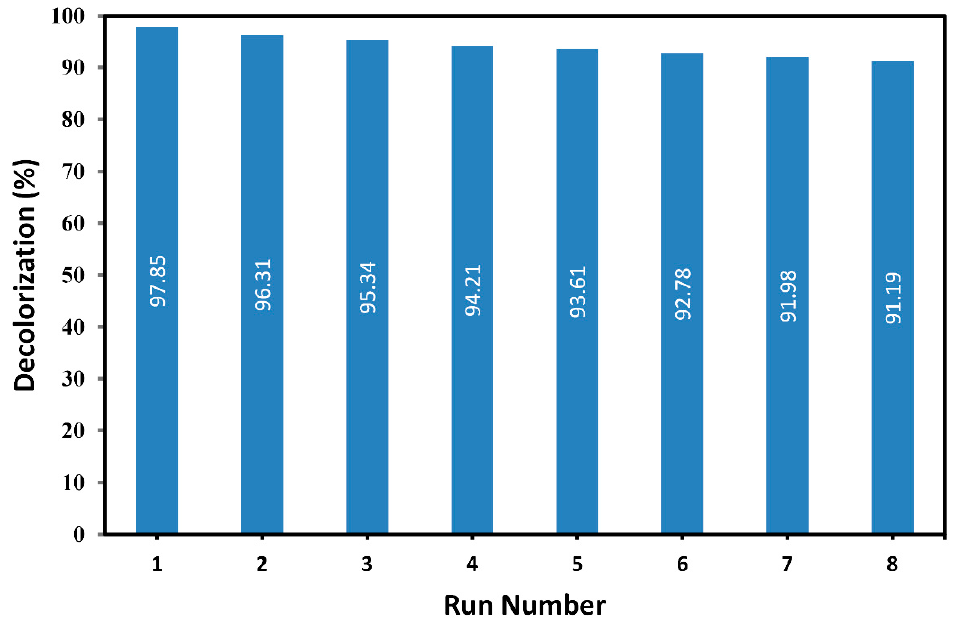
Figure 11. Decolorization efficiency of MG solution in consecutive runs after 40 min; [MG] = 10 mg/L and [H 2 O 2 ] = 13 mM.